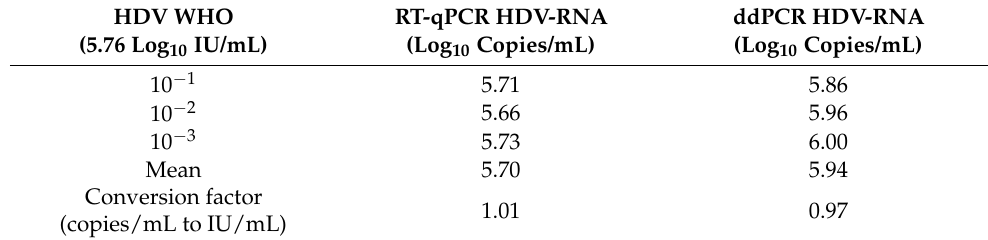
Table 1. Determination of the conversion factor from copies/mL to IU/mL for RT and ddPCR assays.